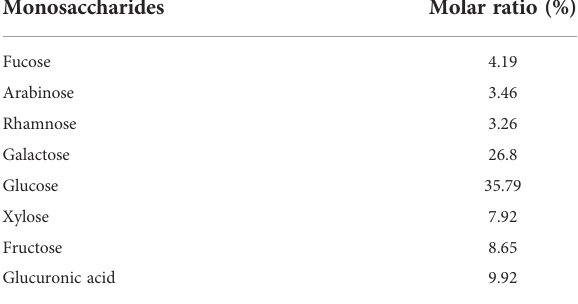
TABLE 5 Monosaccharide composition of SRP.